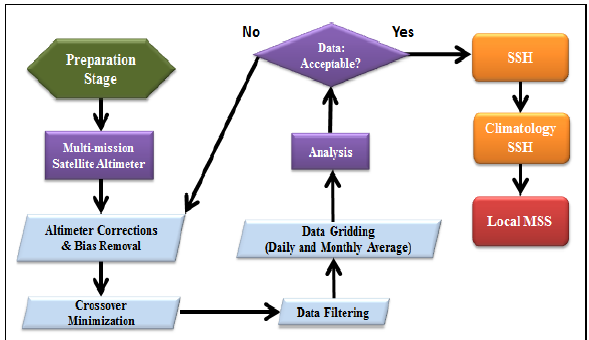
Figure 2. Altimeter Data Processing Flows used in RADS (Modified from Din, et al. (2014))